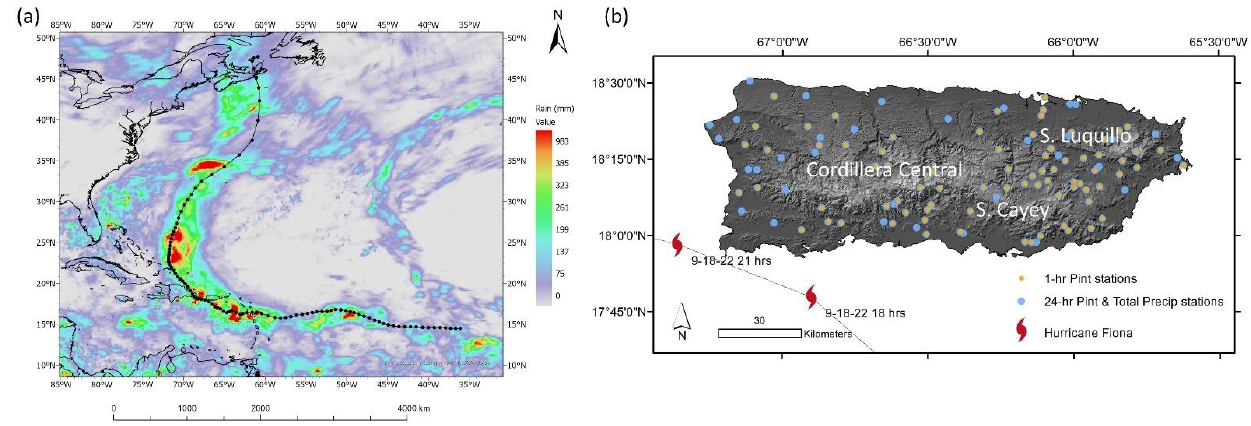
Figure 1. Hurricane Fiona track and location of rainfall measuring stations. ( a ) Complete six-hour timestep track for Hurricane Fiona (19–24 September 2022) and accumulated rainfall estimates from the Global Precipitation Mission [https://gpm.nasa.gov/data; accessed 1 November 2022]. ( b ) Relief map of Puerto Rico showing Hurricane Fiona’s track in the vicinity of Puerto Rico and the location of weather stations measuring 1 h and 24 h rainfall intensities and total rainfall.